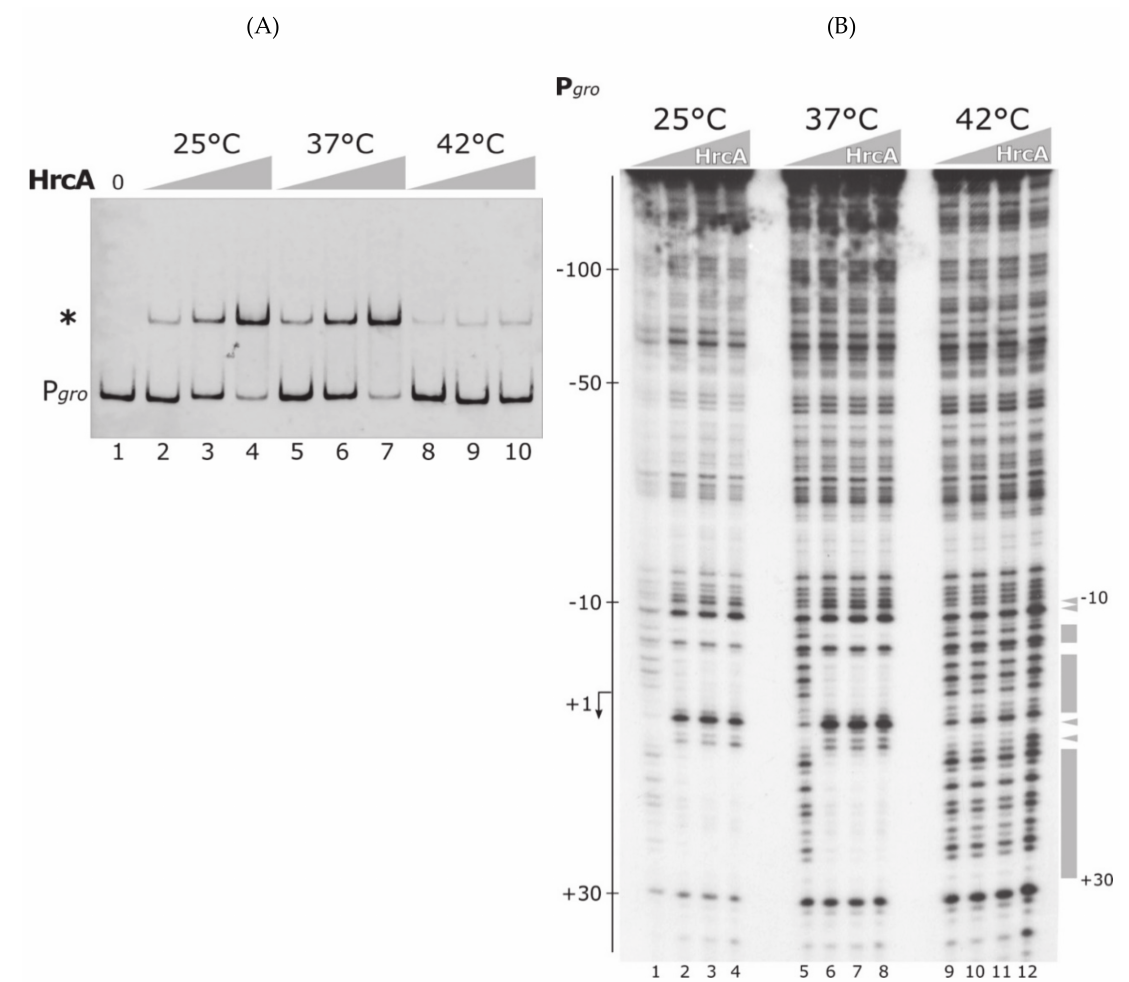
Figure 2. DNA-binding assays of the heat-shock repressor HrcA to the P gro promoter at different temperatures. ( A ) EMSA carried out with purified HrcA on P gro promoter probe. DNA–protein complexes were allowed to form for 10 min at 25 ◦ C, then reactions were moved to different temperatures (25, 37 or 42 ◦ C) for 10 min. An asterisk marks the HrcA shifted band, while the label “P gro ” indicates the free probe. Lanes 1–4 contain 0, 45, 90 and 180 nM HrcA, respectively. Lanes 4–6 and 8–10 contain the same increasing concentrations of HrcA as in samples 2–4. Grey triangles are indicative of HrcA concentrations at the indicated temperatures. ( B ) DNase I footprinting assays with HrcA on P gro labeled probe at different temperatures. Protein–DNA mixes were incubated for 10 min at 25 ◦ C, then moved to different temperatures (25, 37 or 42 ◦ C) for 10 min, before DNase I cleavage. Lanes 1–4, 5–8 and 9–12 contain 0, 90, 180 and 360 nM HrcA, respectively. On the left of the autoradiograph, the numbers refer to the positions with respect to the transcriptional start site (indicated by a bent arrow). Protected regions and DNase I hypersensitive sites are indicated on the right by grey boxes and arrowheads, respectively, together with positions delimiting the HrcA binding site. HrcA concentrations are depicted on top of the figures with grey triangles at the indicated temperatures. Symbol * indicates the HrcA shifted